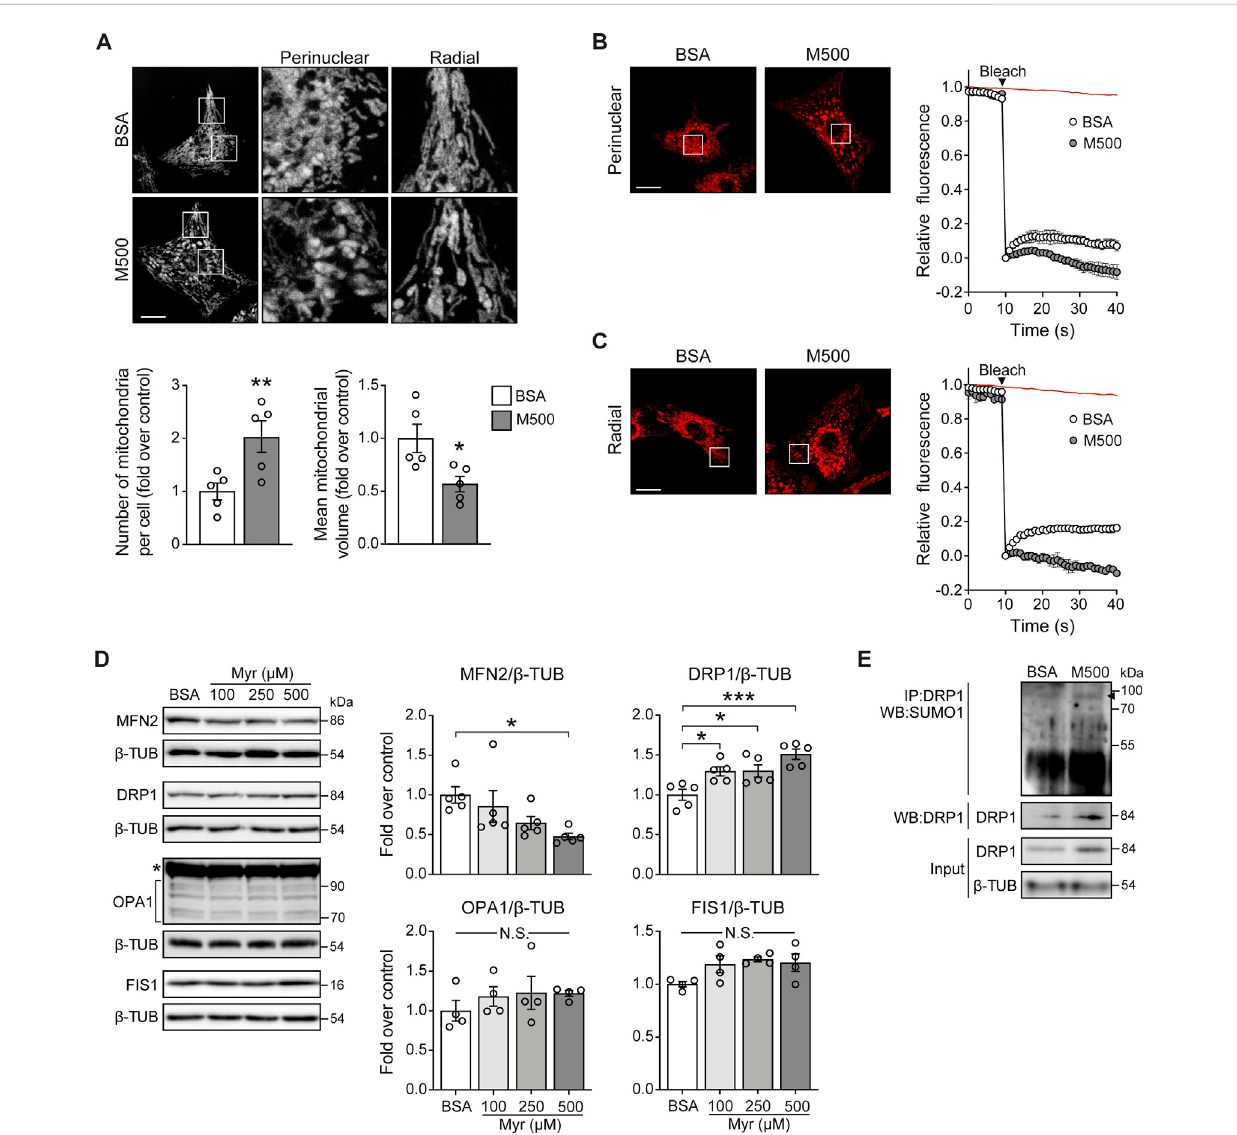
Myristate induces mitochondrial fragmentation in cultured cardiomyocytes. (A) Top : Representative images of NRVM treated with BSA or myristate 500 μ M (M500) for 24 h and stained with MTG to visualize the mitochondrial network. Scale bar = 10 μ m. Bottom : Quanti fi cation of mitochondrial number and average mitochondrial volume (n = 5). (B) Left : Representative image from FRAP analysis of the perinuclear mitochondrial network of NRVM treated with BSA or M500 for 24 h. Bleaching of TMRM fl uorescence was appliedin a square at chosen region (perinuclear). Right : Quanti fi cation of TMRM fl uorescence levels. Fluorescence intensity was normalized to the intensity levels before and after bleaching. Red line in the graph indicates the fl uorescence decay during theacquisition in anon-bleachedarea. (C) Left : Representative imagefrom FRAP analysis ofthe radial mitochondrial network of NRVM treated with BSA or M500 for 24 h. Bleaching of TMRM fl uorescence was applied in a square at chosen region (radial). Right : Quanti fi cation of TMRM fl uorescencelevels. (D) RepresentativeimmunoblotsofMFN2,DRP1,OPA1andFIS1,detectedinNRVMtreatedwithMyr100,250and500 μ M,for 24 h β -TUBULIN ( β -TUB) was used as a loading control. Right : Quanti fi cation of MFN2/ β -TUB, DRP1/ β -TUB, OPA1/ β -TUB and FIS1/ β -TUB (n = 4 – 5). (E) DRP1 SUMOylation (SUMO1) assessed by immunoblot after immunoprecipitation of DRP1 protein from NRVM treated with BSA or myristate 500 μ M (M500) for 24 h. A representative image is shown from three independent experiments with similar outcomes. In all panels: individual data points are shown, and bars represent mean ± S.E.M. Statistical comparisons: * p < 0.05, ** p < 0.01, and *** p < 0.01. N.S: non-signi fi cant.